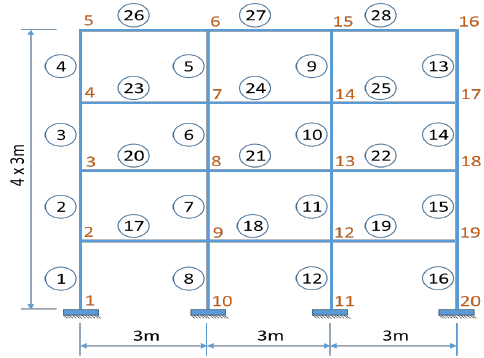
Fig. 1: Sketch of a 4-storey steel frame